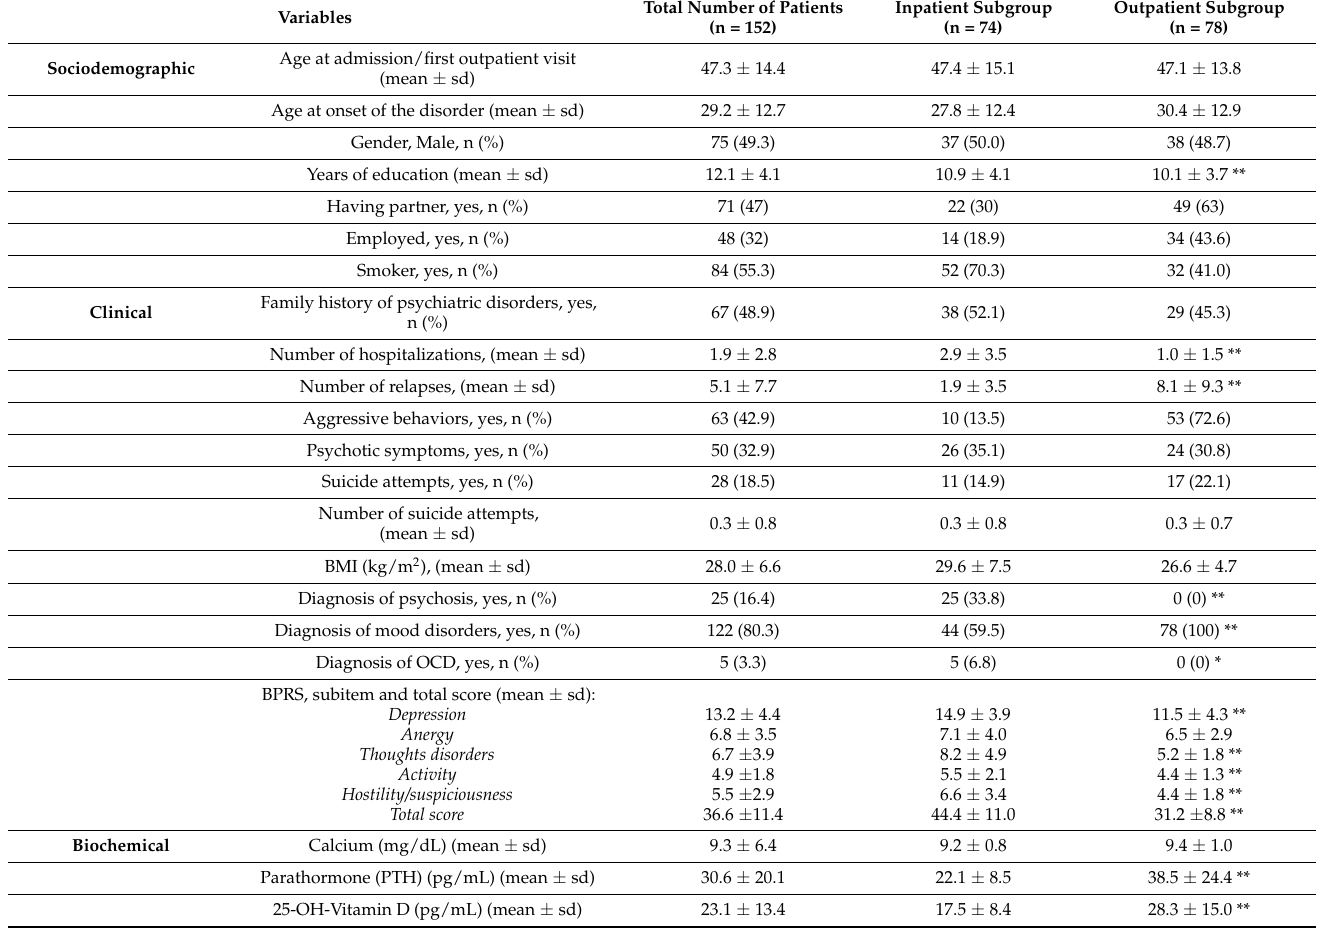
Table 1. Sociodemographic, clinical, and biochemical characteristics of the total number of patients with a psychiatric diagnosis, sub-grouped as inpatients and